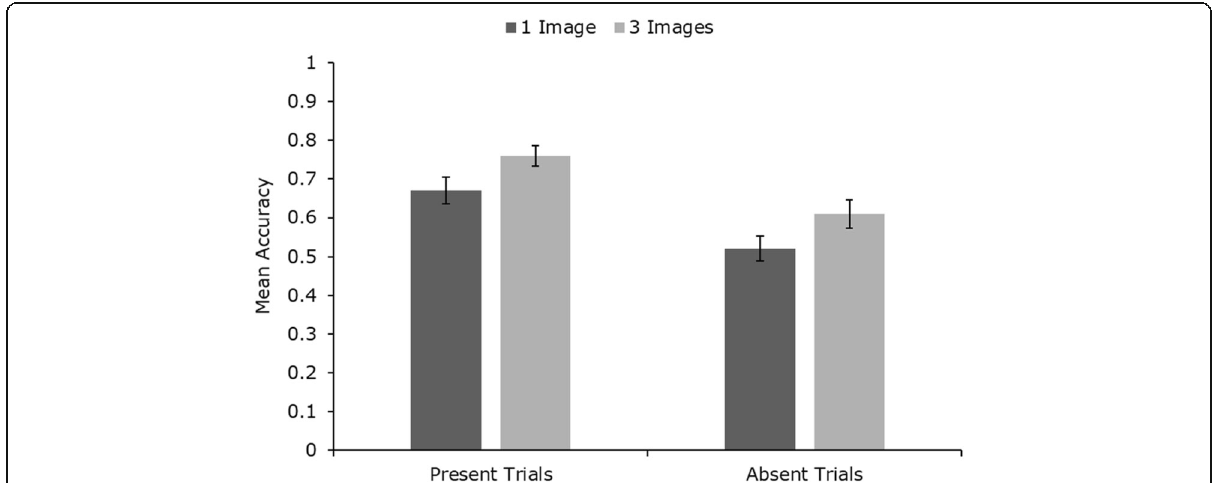
Fig. 2 Mean identification accuracy across conditions in study 1. Error bars represent within-subjects standard error (Cousineau,